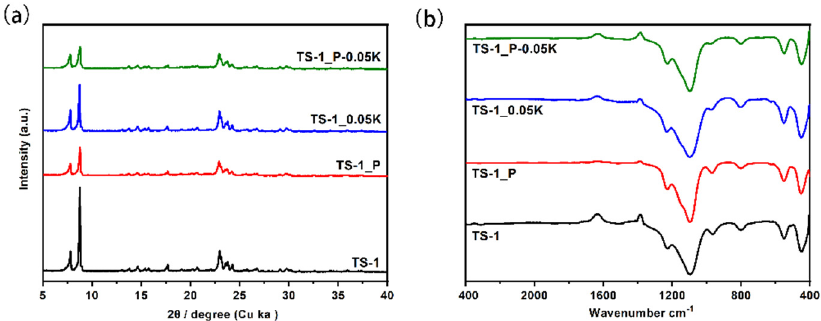
Figure 1. The XRD patterns ( a ) and FTIR spectra ( b ) of the parent TS-1 and post-modified TS-1 zeo-